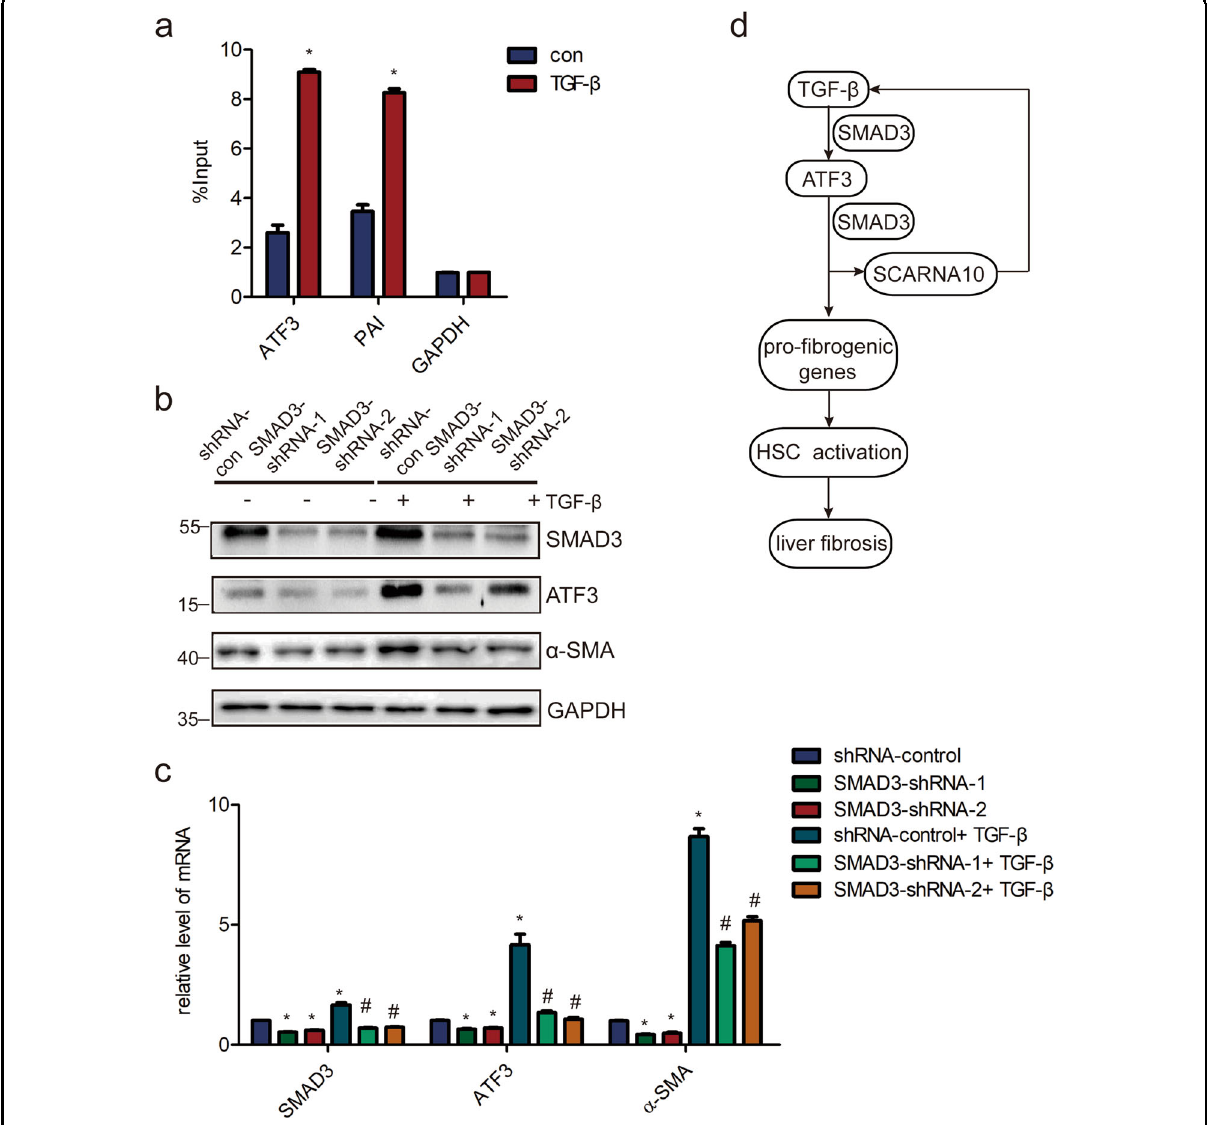
Fig. 7 ATF3 is over-expressed in a TGF- β /SMAD3-dependent manner. a LX-2 cells were treated with TGF- β and ChIP analyses were performed on ATF3 promoter regions, using anti-SMAD3 antibody. Enrichment was shown relative to input; * p < 0.05. b , c LX-2 cells were infected with lentivirus-mediated shSMAD3-1/2 for 72 h and further treated with 10 ng/ml TGF- β for additional 24 h. The level of SMAD3, ATF3, and α -SMA were detected by western blot and qRT-PCR. d Schematic representation of the TGF β /ATF3/lnc-SCARNA10 pathway and its function in the progression of liver fi brosis. The data were expressed as the mean ± SEM for at least triplicate experiments. GAPDH was used as an internal control; */# p < 0.05, * p < 0.05 for vs shRNA control, # p < 0.05 for vs shRNA control + TGF- β